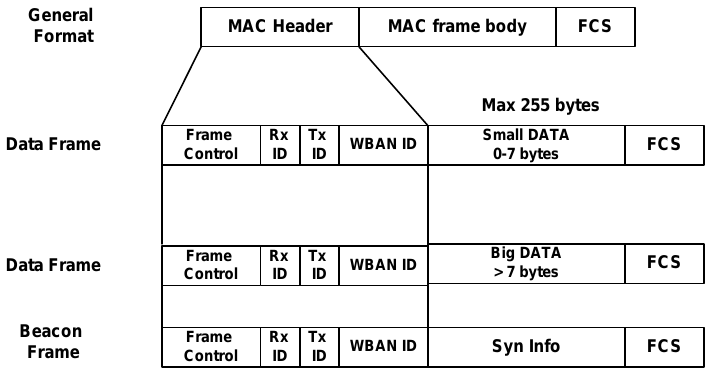
Figure 4. MAC frame format of